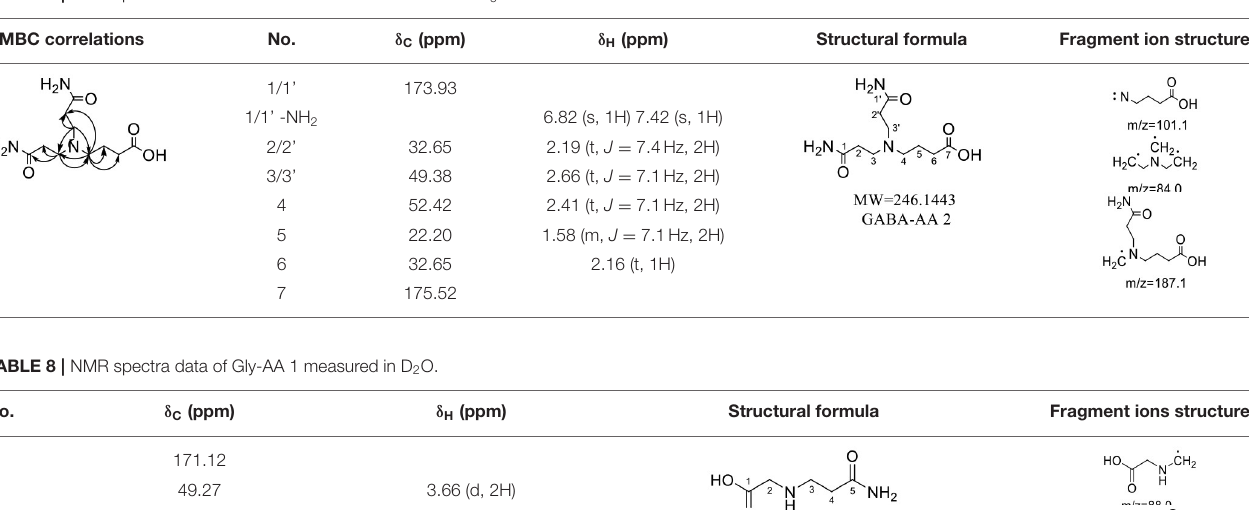
TABLE 7 | NMR spectra data of GABA-AA 2 measured in DMSO-d 6 .